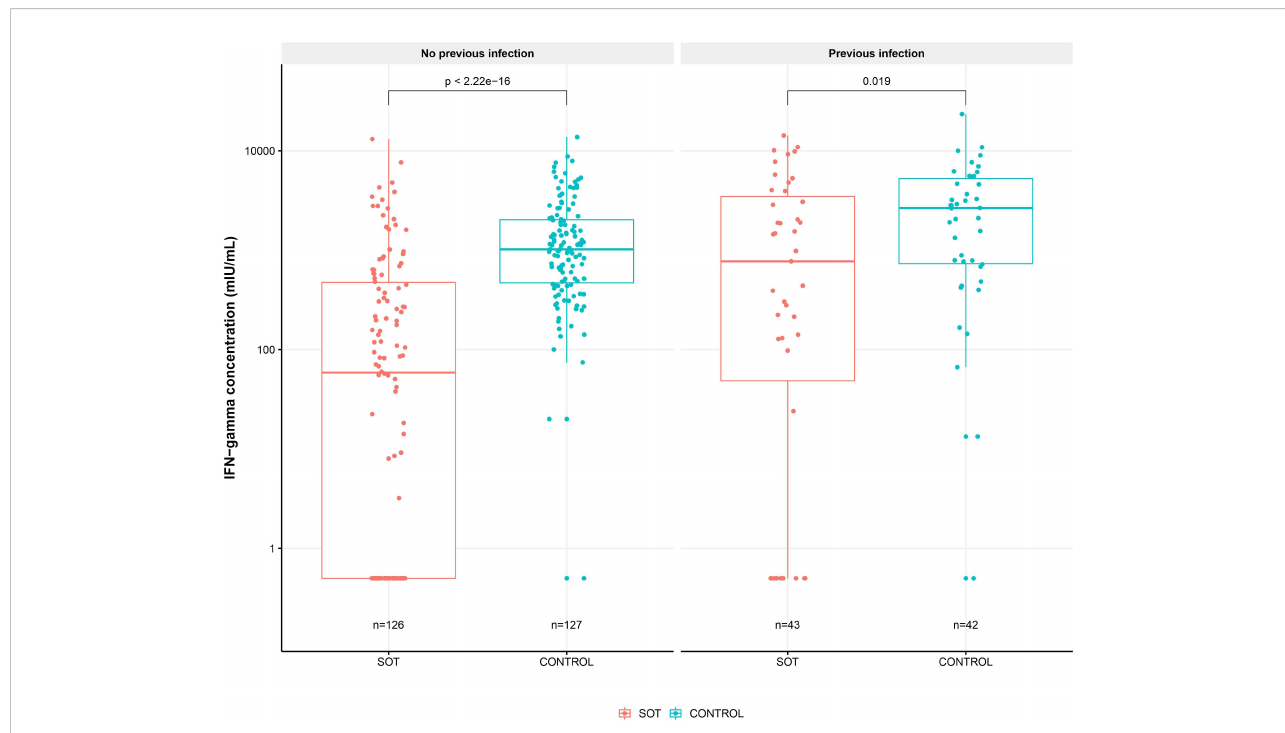
FIGURE 5 SARS-CoV-2 Spike protein speci fi c T-cell response 12 months after fi rst BNT162b2 dose in solid organ transplant (SOT) recipients and controls with and without previous SARS-CoV-2 infection. Boxplots of spike-speci fi c interferon gamma concentration in mIU/mL in solid organ transplant (SOT) recipients and controls with and without previous infection 12 months after fi rst vaccine dose. The y axis shows spike-speci fi c interferon gamma concentration in mIU/mL on a log10 scale and the x axis the number of SOT recipients and controls in each group. Differences between SOT recipients and controls was tested with Mann-Whitney U test and p values shown on the plot.